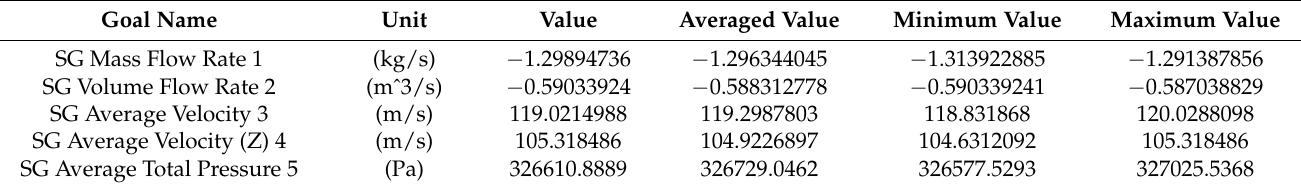
Figure 13. ( a ) The velocity flow trajectory results of the air for the no-fin design at the exit of the combustion chamber, ( b ) the velocity flow trajectory of the air for the one-fin design, ( c ) the velocity flow trajectory for the two-fin design, ( d ) the turbulent viscosity flow trajectory results for the no-fin design, ( e ) the turbulent viscosity flow trajectory of the air for the one-fin design, ( f ) the turbulent viscosity flow trajectory results for the two-fin design. In addition to the flow trajectory results, the numerical results are added in Tables 2– 4. Additionally, in Figures 14–16, graphs show the mass and volume flow rate of each design. Table 2. Numerical results of mass and volume flow rate for the compressor outflow (Figure 8).